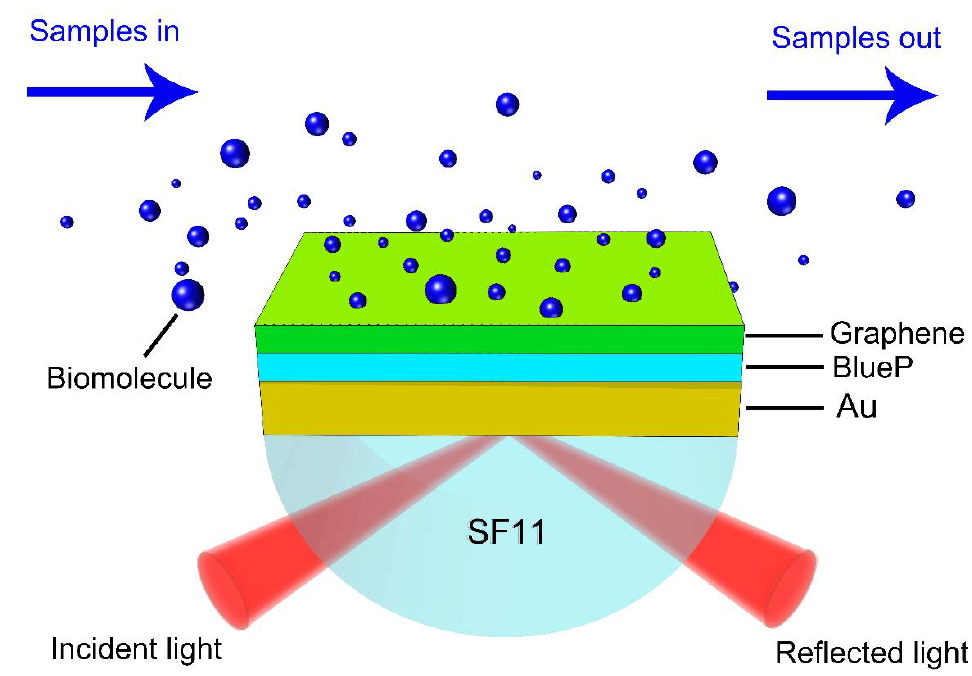
Figure 1. Schematic diagram of the SF11 prism/Au film/ BlueP/graphene biosensor.